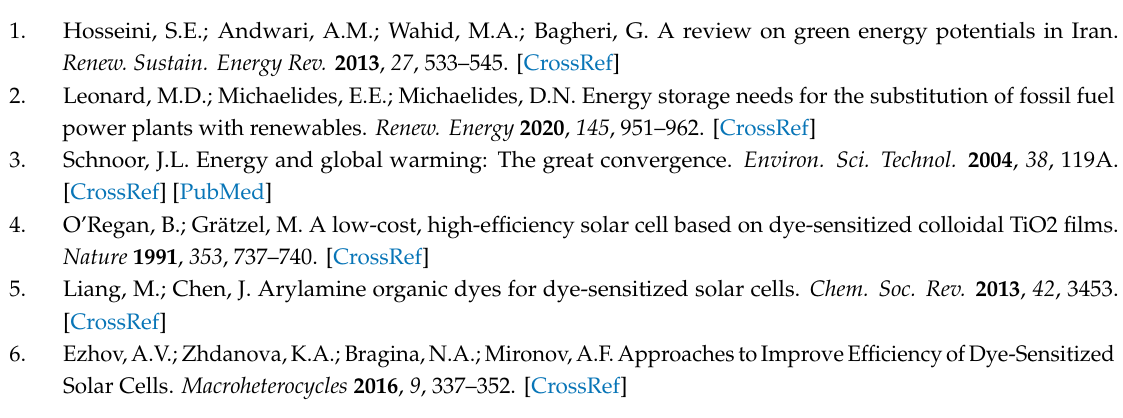
Supplementary Materials: The following are available online. Figure S1: UV-Vis absorption spectra of carbazole-based dyes with the CAM-B3LYP / 6-31G(d) level of theory, Table S1: Chemical reactivity parameters of carbazole-based dyes (in eV) obtained by DFT conceptual at CAM-B3LYP / 6-31G(d) level of